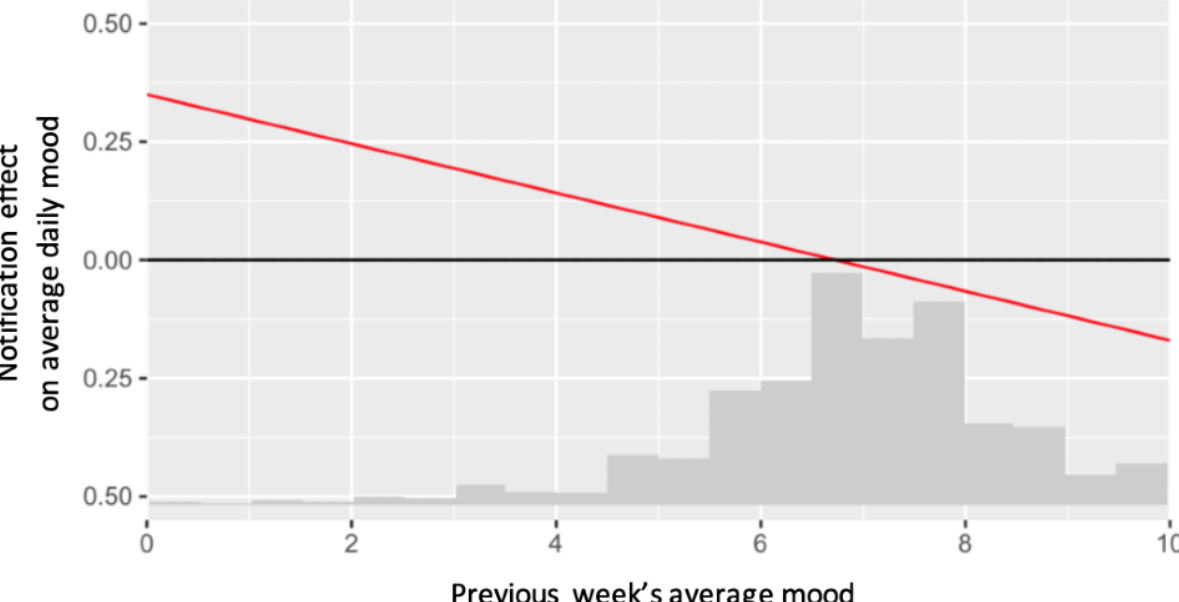
Figure 4. Estimated treatment effects (compared with no notifications) of notifications on average daily mood, at various values of previous week’s mood. The x-axis also contains a scaled histogram of previous week’s average